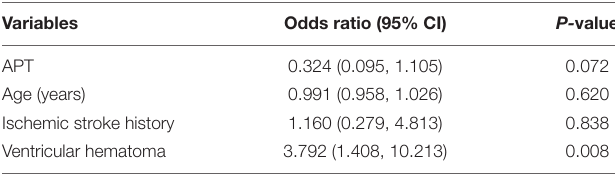
TABLE 4 | The effects of APT on outcomes after